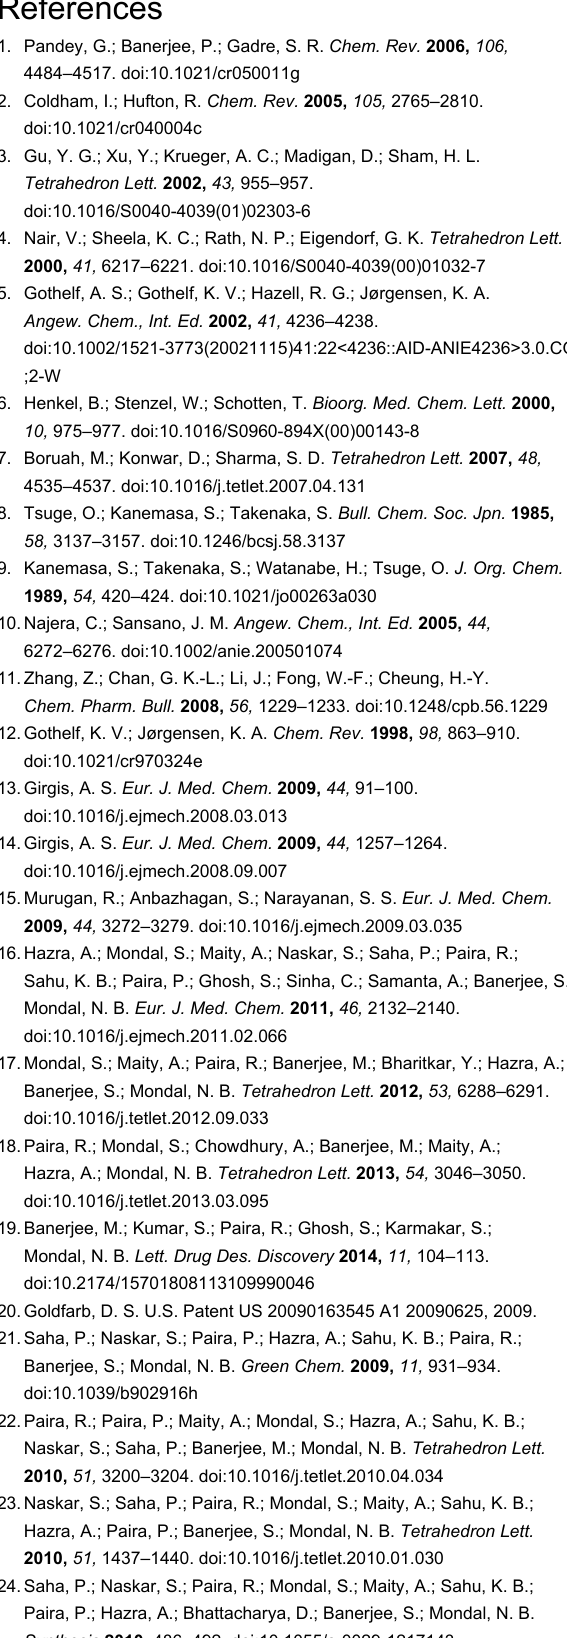
Figure 3: ORTEP diagram showing the molecular structure of 14e at 30% probability level.